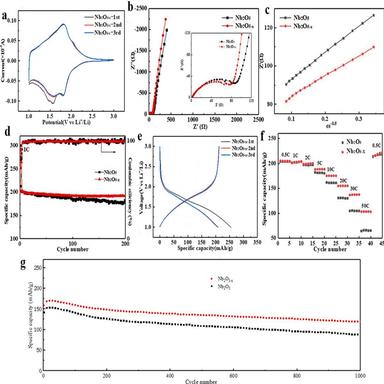
(a) CV curves of the Nb2O5-x at 0.1 mV s − 1 , (b) EIS spectra of the Nb2O5-x, (c) The plots of real part of impedance (Zre) as a function of the inverse square root of the angular frequency (ω-1/2) in the Warburg region of Nb2O5-x and Nb2O5, (d) cycling performances of the Nb2O5-x and Nb2O5 at 1C, (e) GCD profiles of the Nb2O5-x, (f) rate performances of the Nb2O5-x and Nb2O5, (g) cycling performances of the Nb2O5-x and Nb2O5 at 10C.